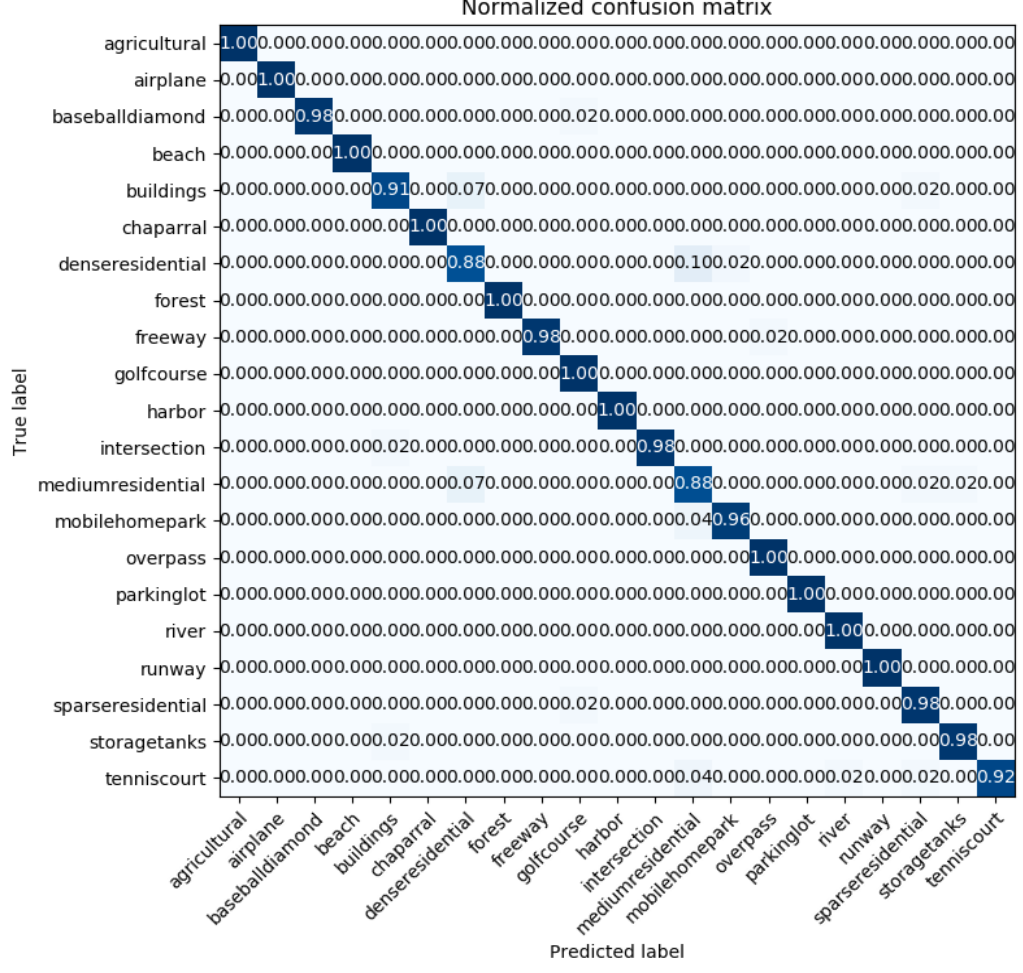
Figure 8. The confusion matrix of the examined method, with 50% of the UC-Merced dataset as a training set for InceptionV3 mixed_8 (PCA) + Xception average pooling. The highlighting of the confusion matrix is a heat map, where white represents 0s, and dark blue represents 1s.